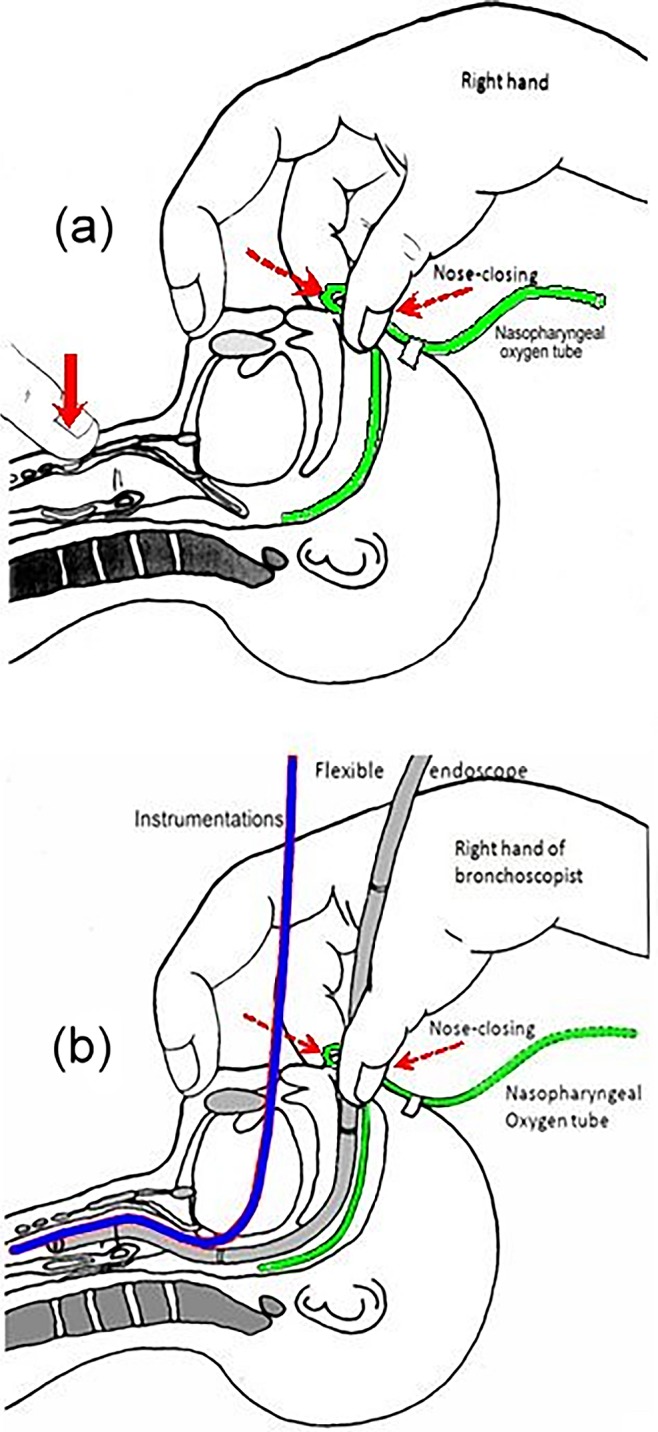
Diagram of “nasopharyngeal oxygen with intermittent nose-closure” ventilation.Done alone (a), or coupled with therapeutic flexible bronchoscopy (b).